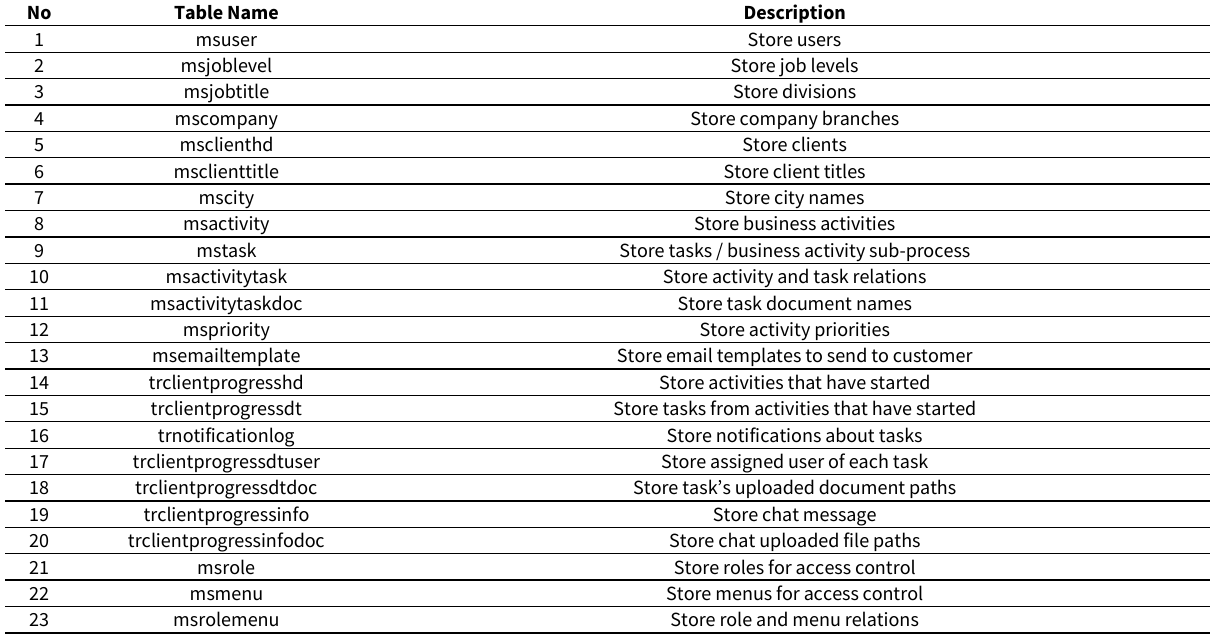
Figure 4. User Controller CRC Table 4.